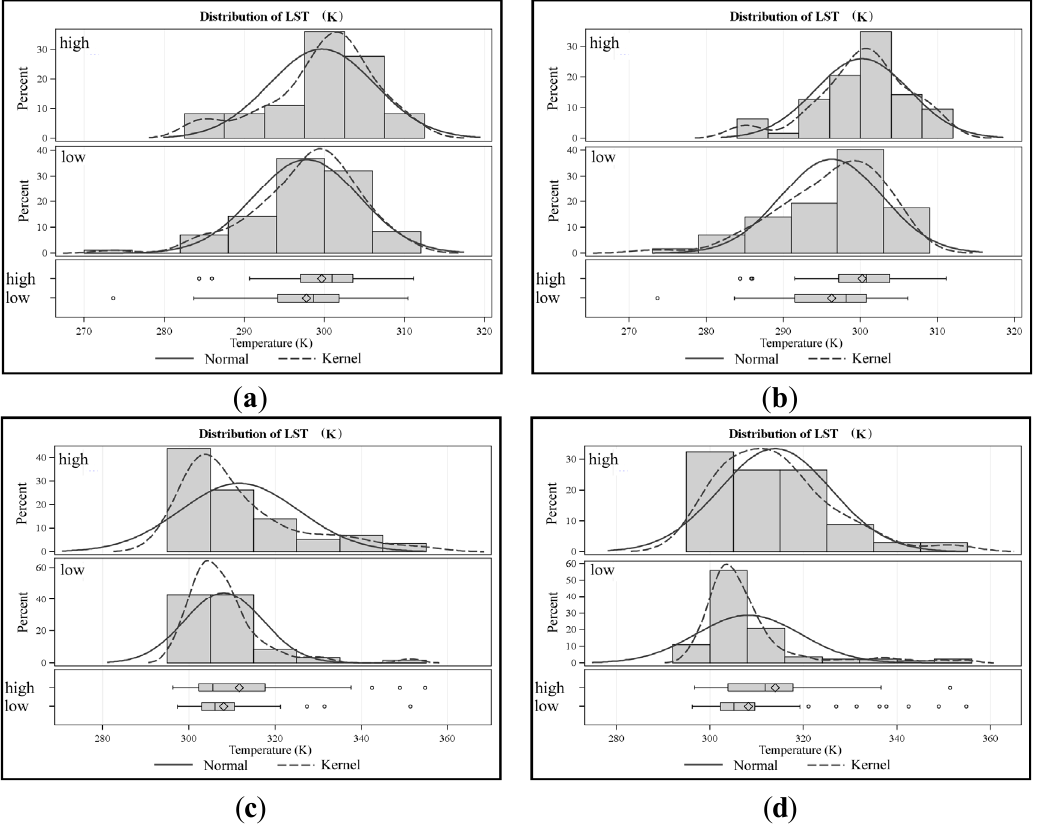
Figure 7. Distribution of temperature points for sets: ( a ) March (daytime); ( b ) March (nighttime); ( c ) June (daytime); and ( d ) June (nighttime). Points inside coal fire areas were identified as high-temperature. Points outside the fire area were identified as having low